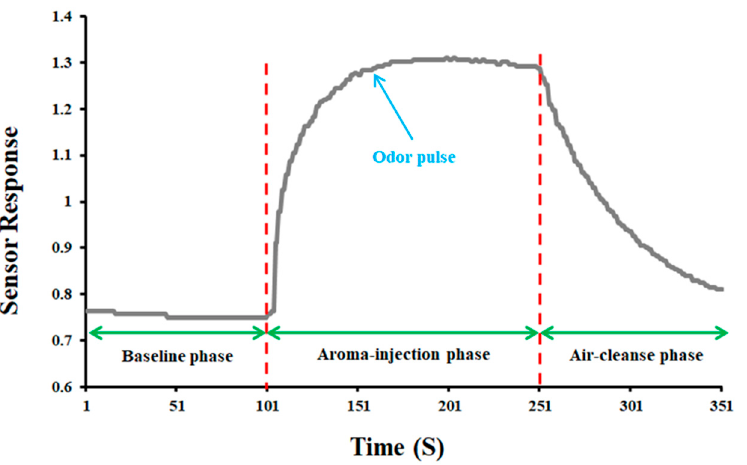
Figure 2. Sensor TGS-813 response to sample VOCs during the e-nose run cycle.